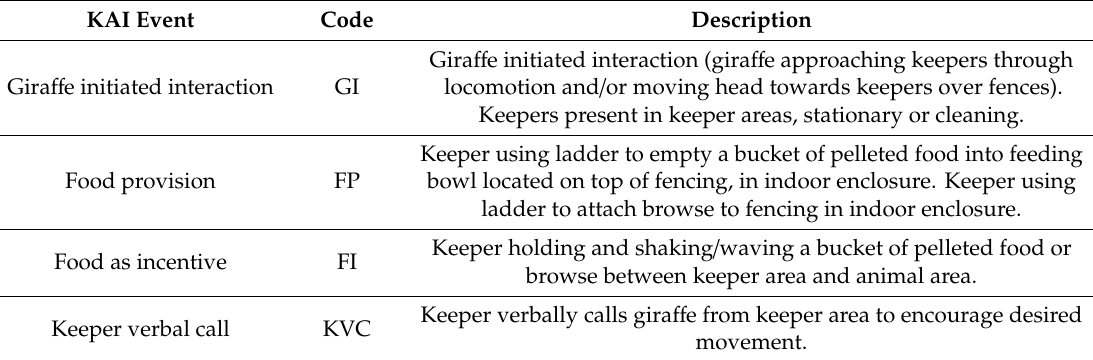
Table 1. Categories of keeper-animal interaction (KAI) events included within this study.